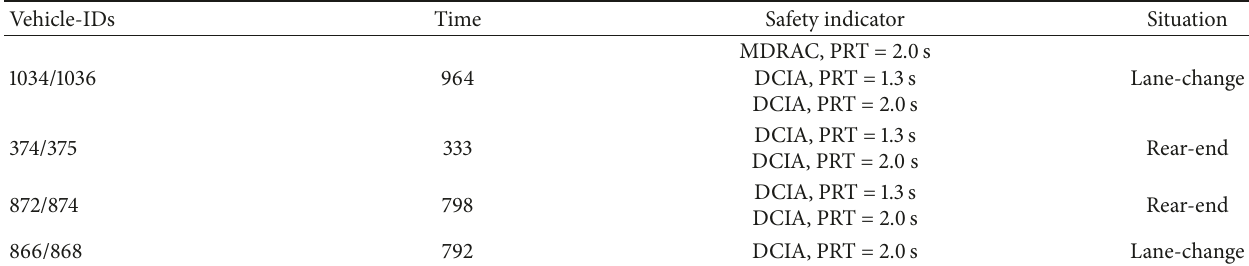
Table 1: Detailed information about the four identified critical